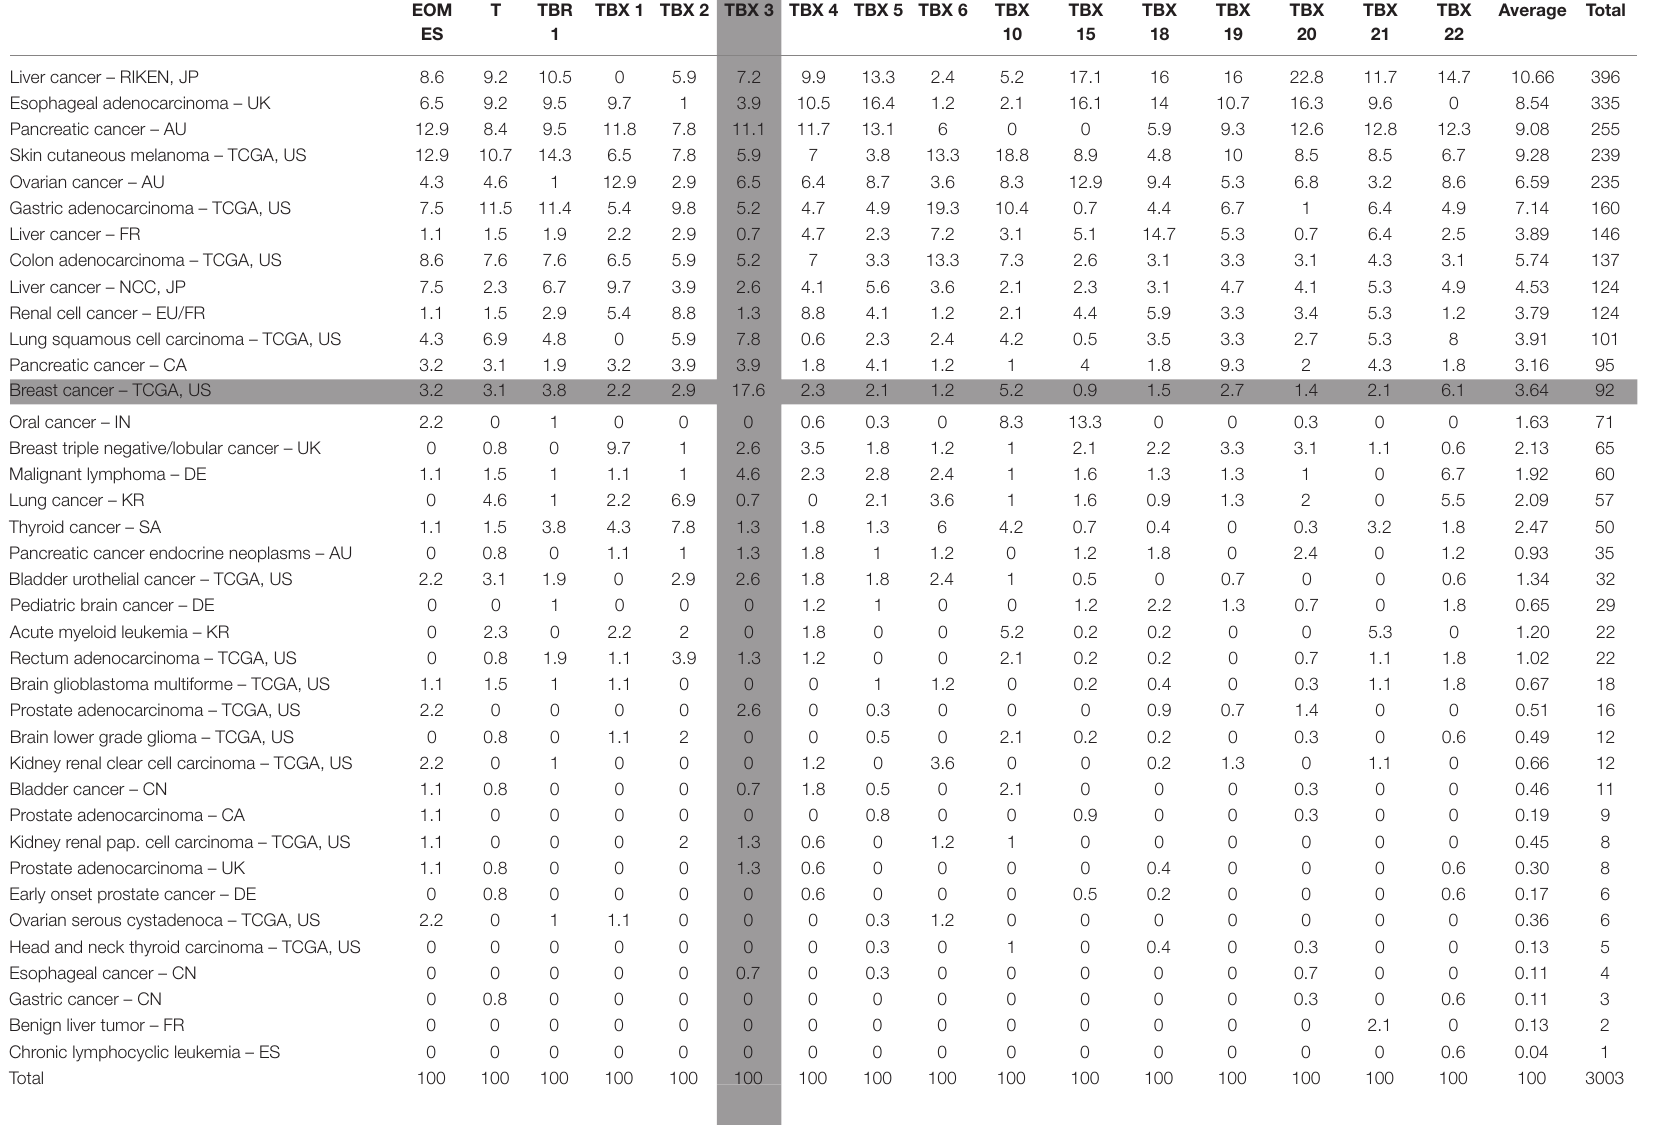
TaBle 1 | relative frequency of TBX mutations in icgc somatic cancer mutation data